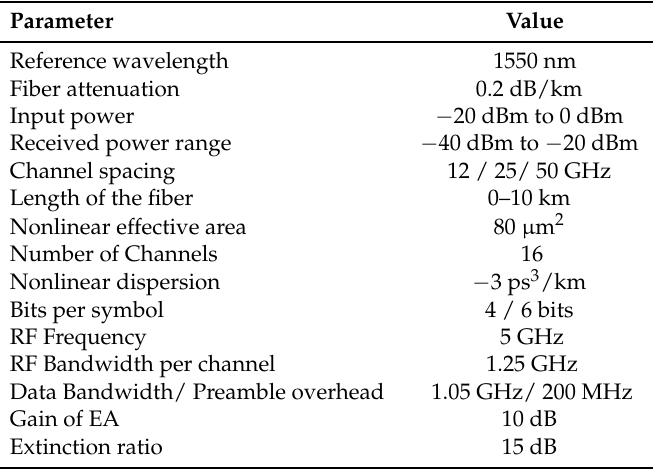
Figure 1. ( a ) Wavelength division multiplexing (WDM)-based Radio over Fiber (RoF) proposed model using 16 and 64 quadrature amplitude modulation (QAM)-orthogonal frequency division multiplexing (OFDM) modulation schemes, ( b ) Internal schematic diagram of FDE block. Table 1. Simulation parameters with their values and